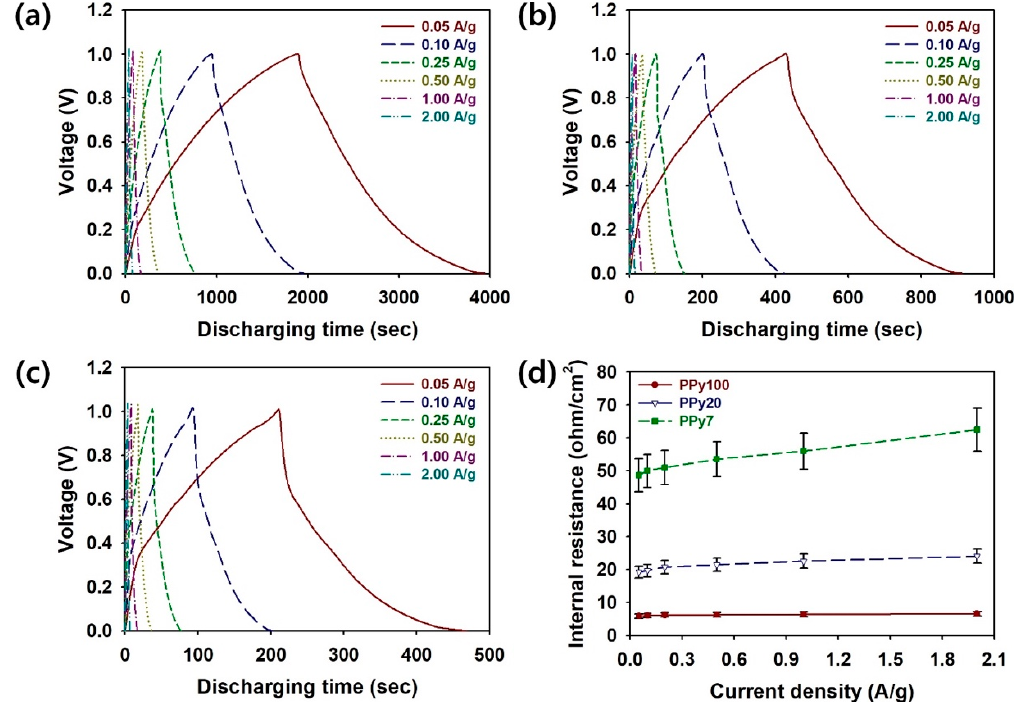
Figure 6. Galvanostatic charge/discharge (GCD) curves of coin cells employing ( a ) Polypyrrole:Poly(4-styrenesulfonate (PPy:PSS) with a PSS molecular weight of 1.0 × 10 6 g/mol (PPy100), ( b ) PPy:PSS with a PSS molecular weight of 2.0 × 10 5 g/mol (PPy20), and ( c ) PPy:PSS with a PSS molecular weight of 7.0 × 10 4 g/mol (PPy7) at current densities. ( d ) Internal resistance values of coin cells employing Polypyrrole:Poly(4-styrenesulfonate) (PPy:PSS) with different average molecular weights at different current densities.